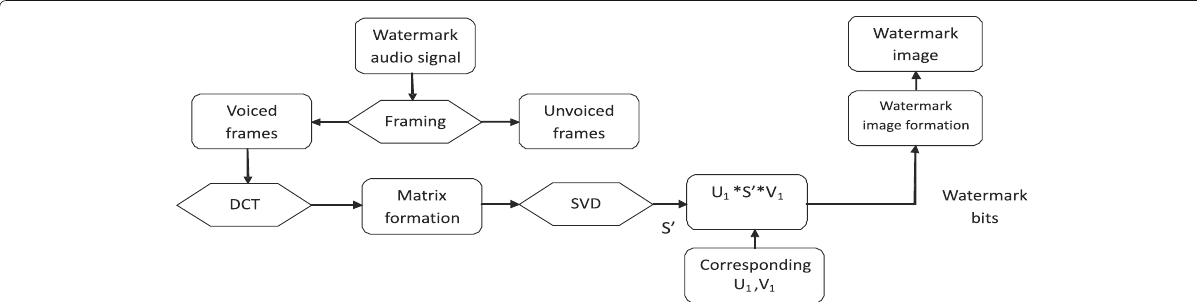
Fig. 5 Extraction procedure: The block diagram shows the major steps involved in extraction of watermark image from watermarked audio signal using proposed DCT-SVD technique